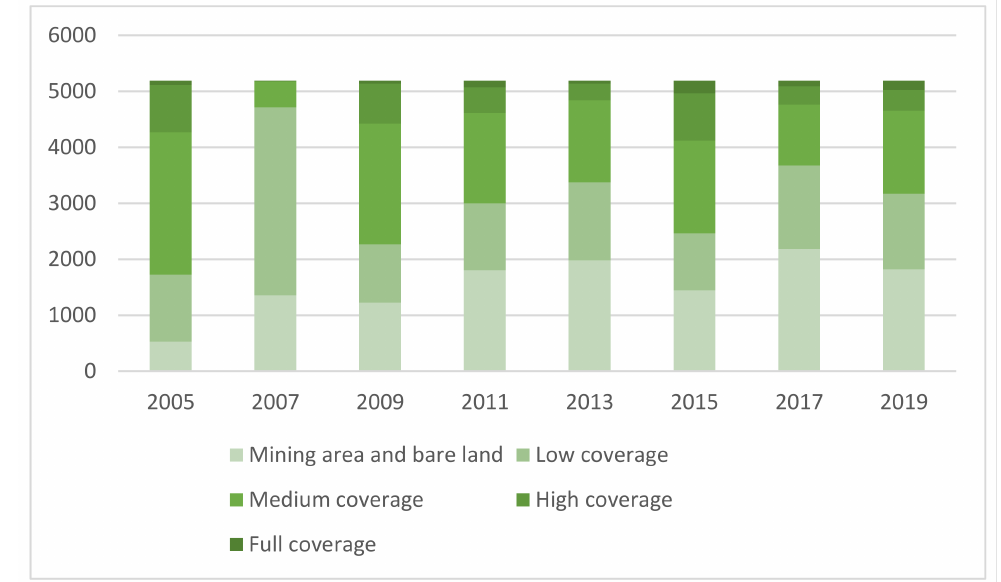
Figure 6. Statistics of mining land and bare land and vegetation area of various levels in the study area from 2005 to